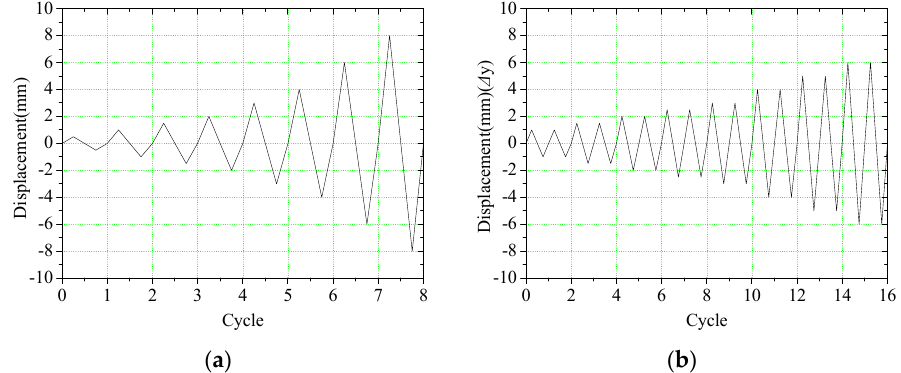
Figure 6. Loading scheme: ( a ) before yielding; ( b ) after yielding.